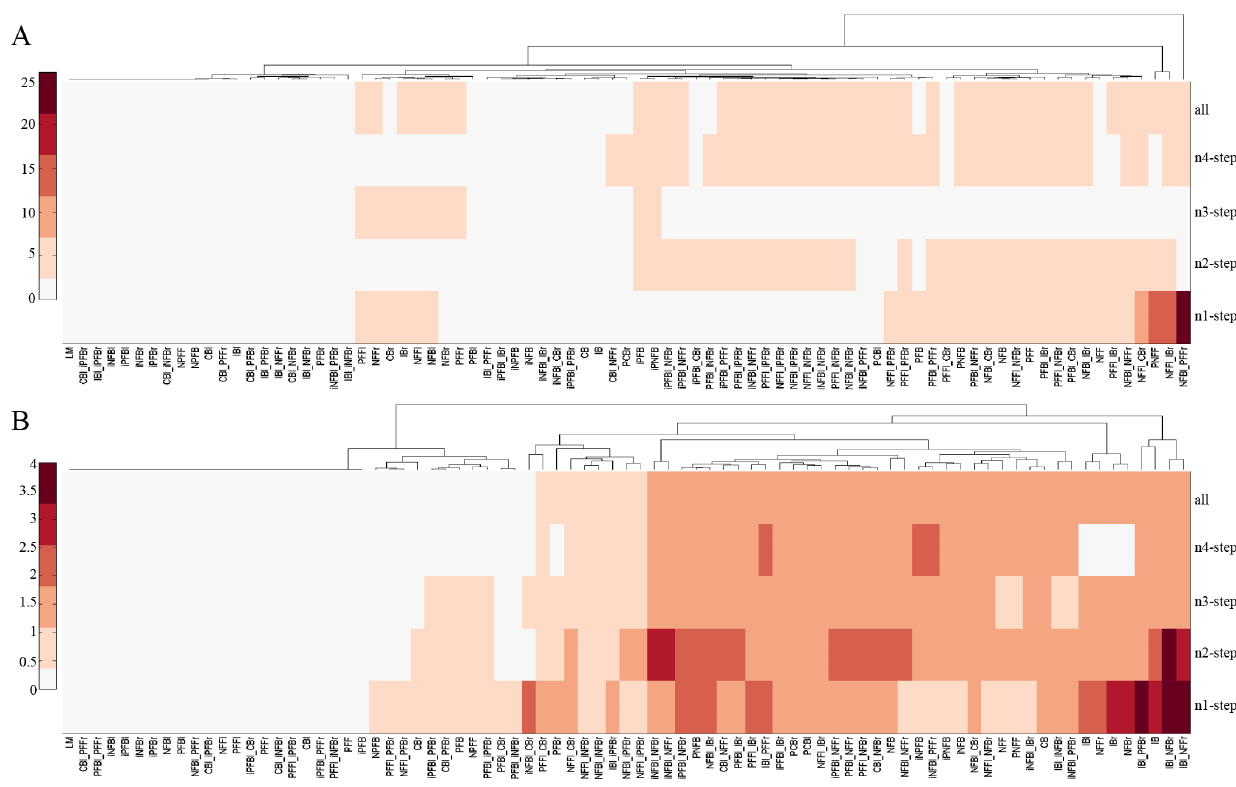
Figure 4. Robustness index heatmaps of the 81 motif topologies with respect to i-step neighbors. A: Robustness of functional tunability to slowly decaying responses. B: Robustness of functional tunability to pulse responses. Given the 81 motif topologies, 2 time-course objectives, and 20 attempts to identify the model parameter, PSO was implemented 3,240 times.